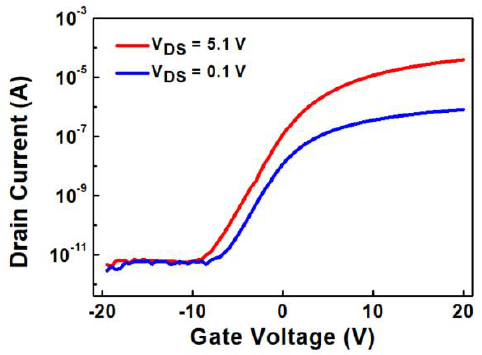
Figure 7. Transfer characteristic of the depletion-mode TFT.